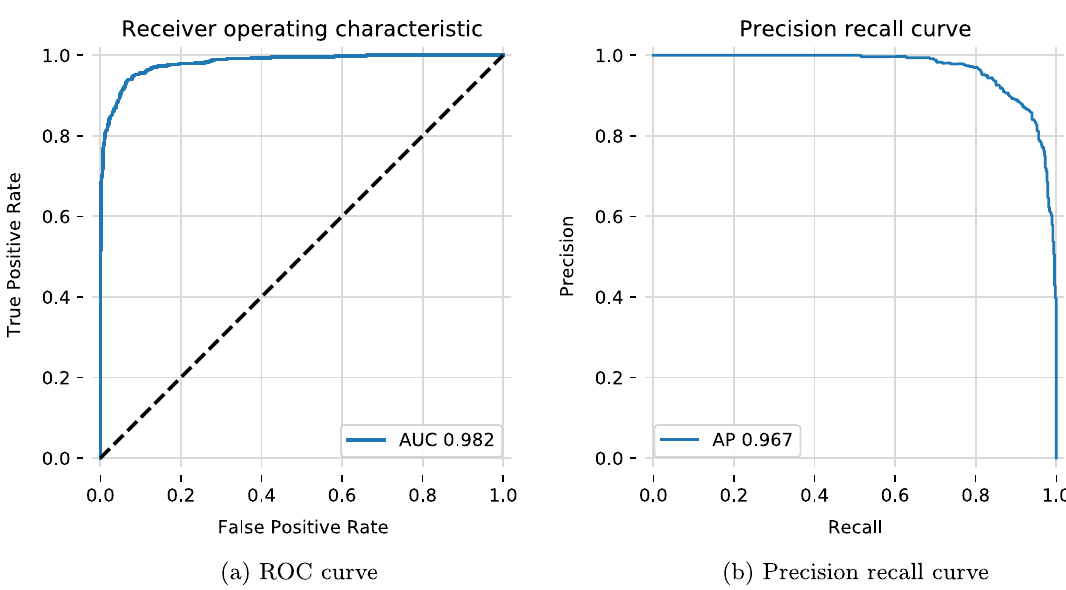
Figure 4. Loss and accuracy of the proposed model based on a single split in the cross-validation procedure.